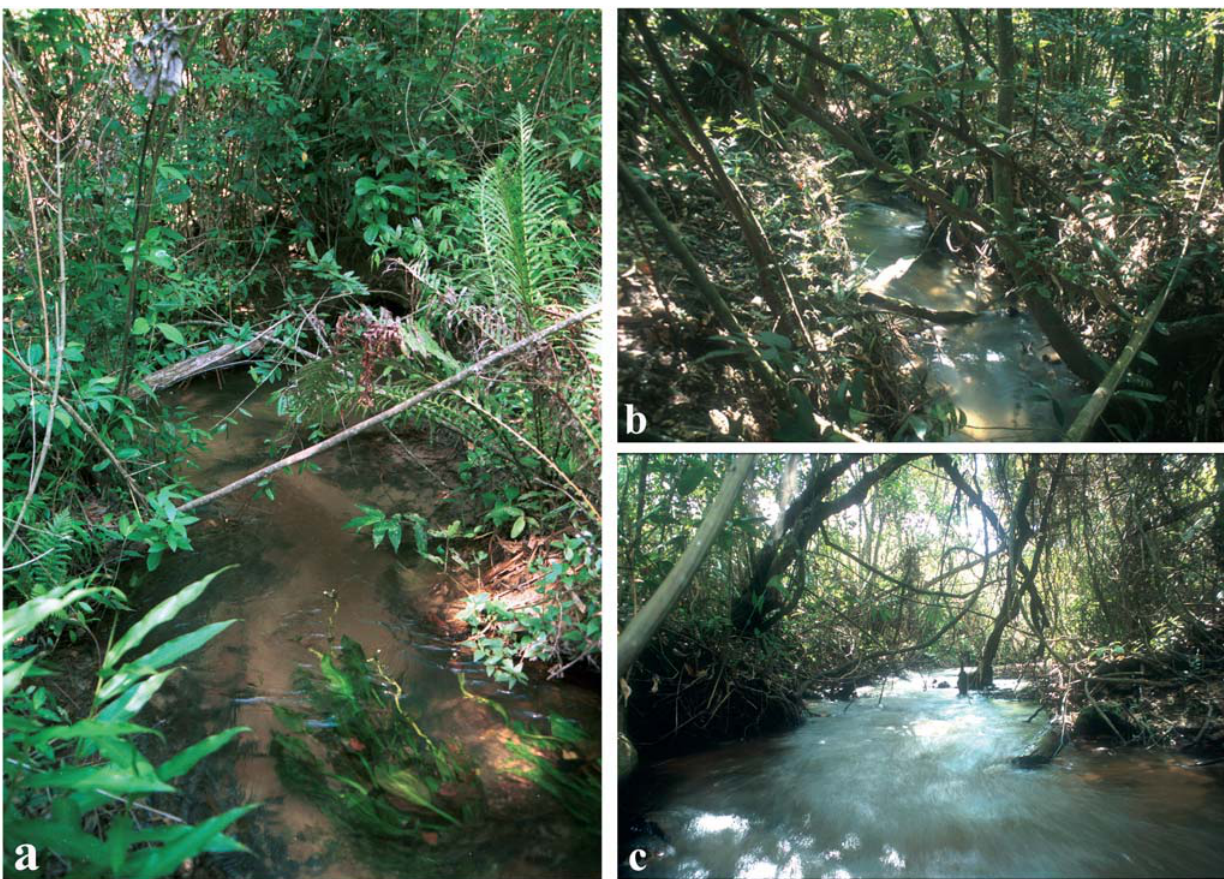
Fig. 2. General view of the three studied stretches in the Paulicéia stream, Mogi-Guaçu River basin; a) upper stretch, b) middle stretch and c) lower